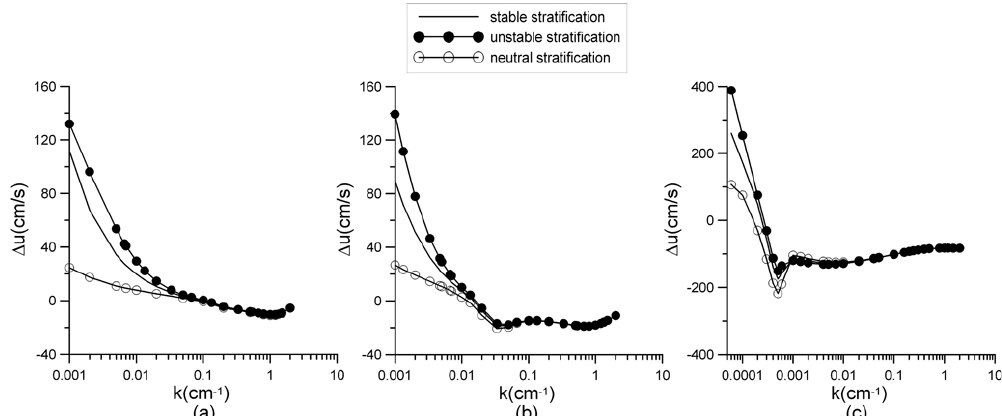
Fig. 5. Dependencies of the nonlinear additives to the wind velocity profiles on a wave number. Wave steepness ka=0.1, (a) u ∗ = 5cms − 1 , (b) u ∗ = 10cms − 1 , and (c) u ∗ = 50cms − 1